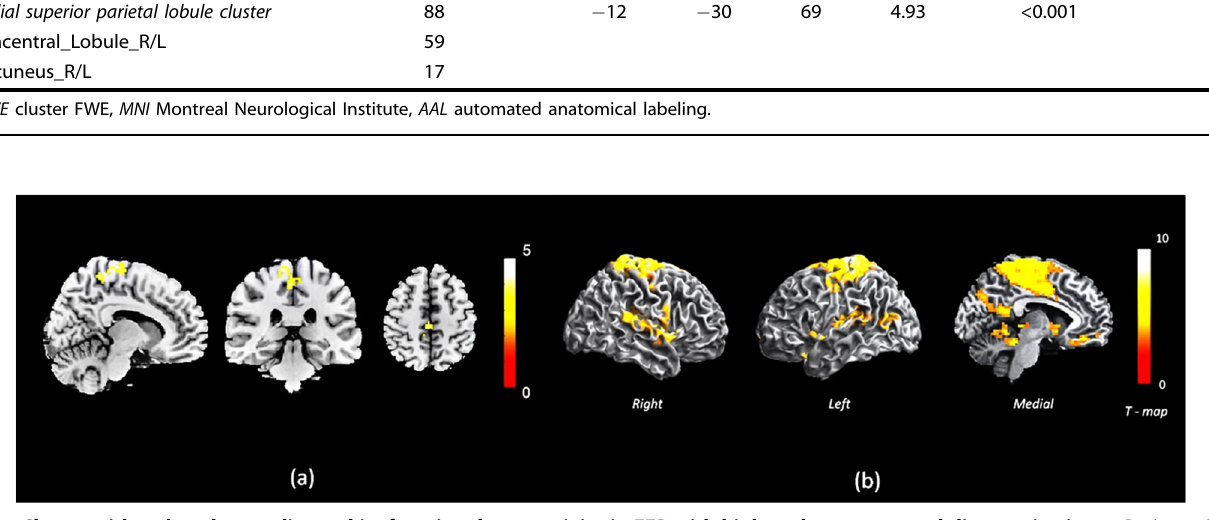
Fig. 2 Cluster with reduced centrality and its functional connectivity in FEP with high vs. low conceptual disorganisation. a Brain regions showing reduced centrality in the High P2 group ( n = 12) compared to the Low P2 group ( n = 26). b Functional connectivity of the medial superior parietal lobule cluster to other brain areas in the FEP group ( n = 38). The colour bars indicate T -values.